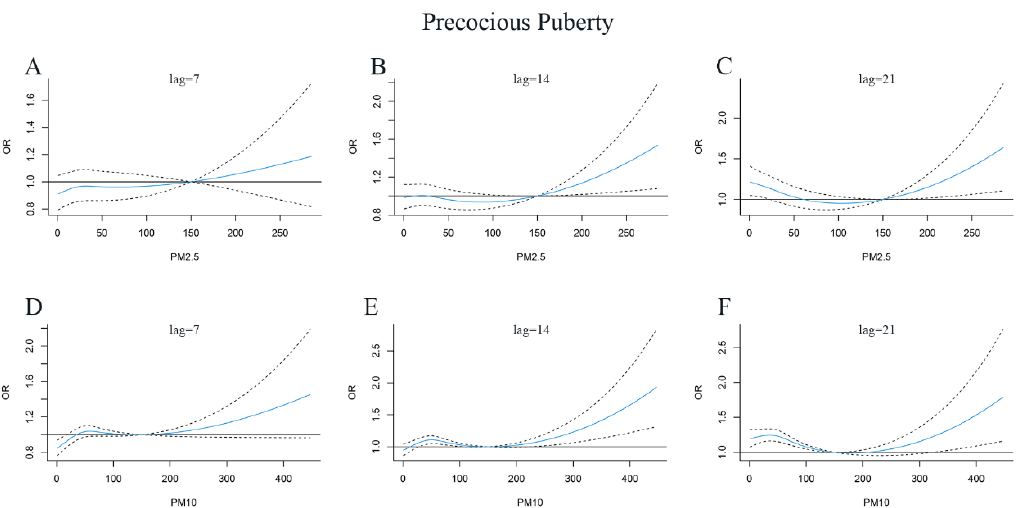
Figure 3. Lag-specific odds ratio (OR) and 95% confidence interval (CI) of precocious puberty with up to 28 days of exposure to PM 2.5 and PM 10 . ( A ): PM 2.5 , lag = 7, ( B ): PM 2.5 , lag = 14, ( C ): PM 2.5 , lag = 21, ( D ): PM 10 , lag = 7, ( E ): PM 10 , lag = 14, ( F ): PM 10 , lag = 21. The dotted line and solid line indicate OR and 95% CI, respectively.